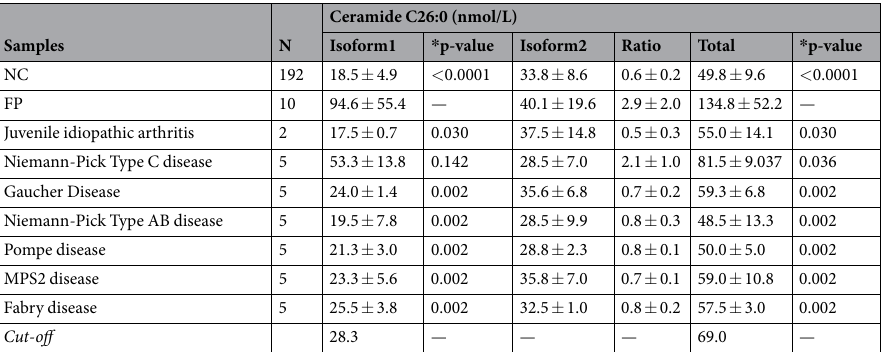
Table 4. Quantification of total C26 ceramide and its isoforms in NC group and different pathological entities. * p-value found in Mann-Whitney test for FP vs. affected